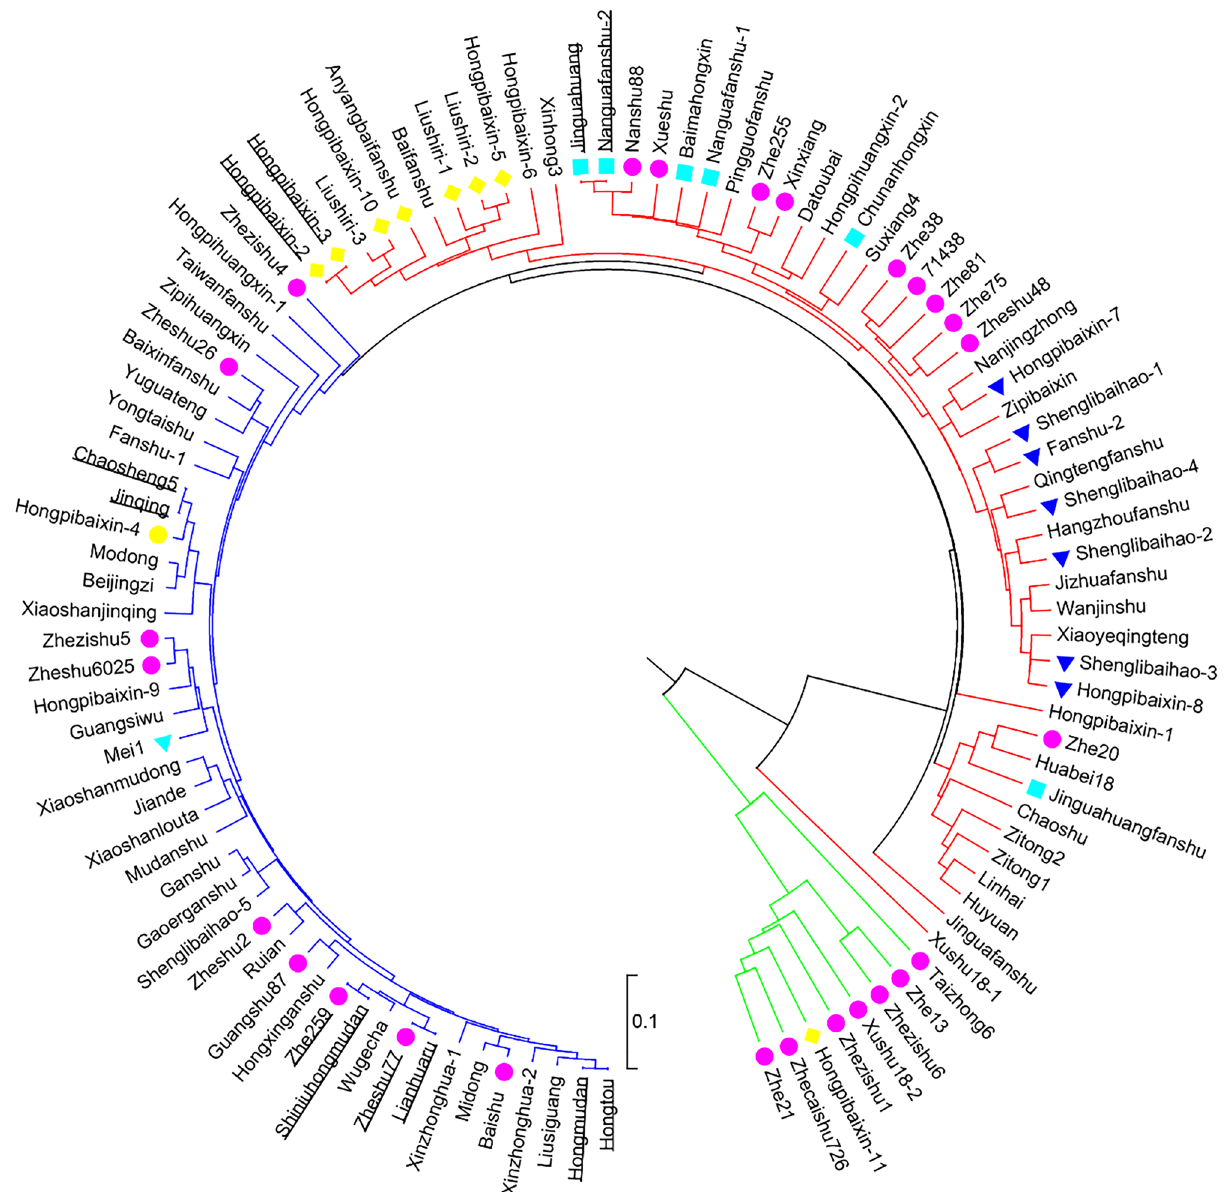
Figure 4. Dendrogram of 105 sweet potato accessions based on their genetic distances. UPGMA cluster analysis based on Dice’s similarity coefficients (Nei and Li, 1979) was used to generate the dendrogram. ‘Green branches’, ‘red branches’ and ‘blue branches’ represent the subbranches. Purple circles indicate improved varieties. Green triangles represent foreign varieties.